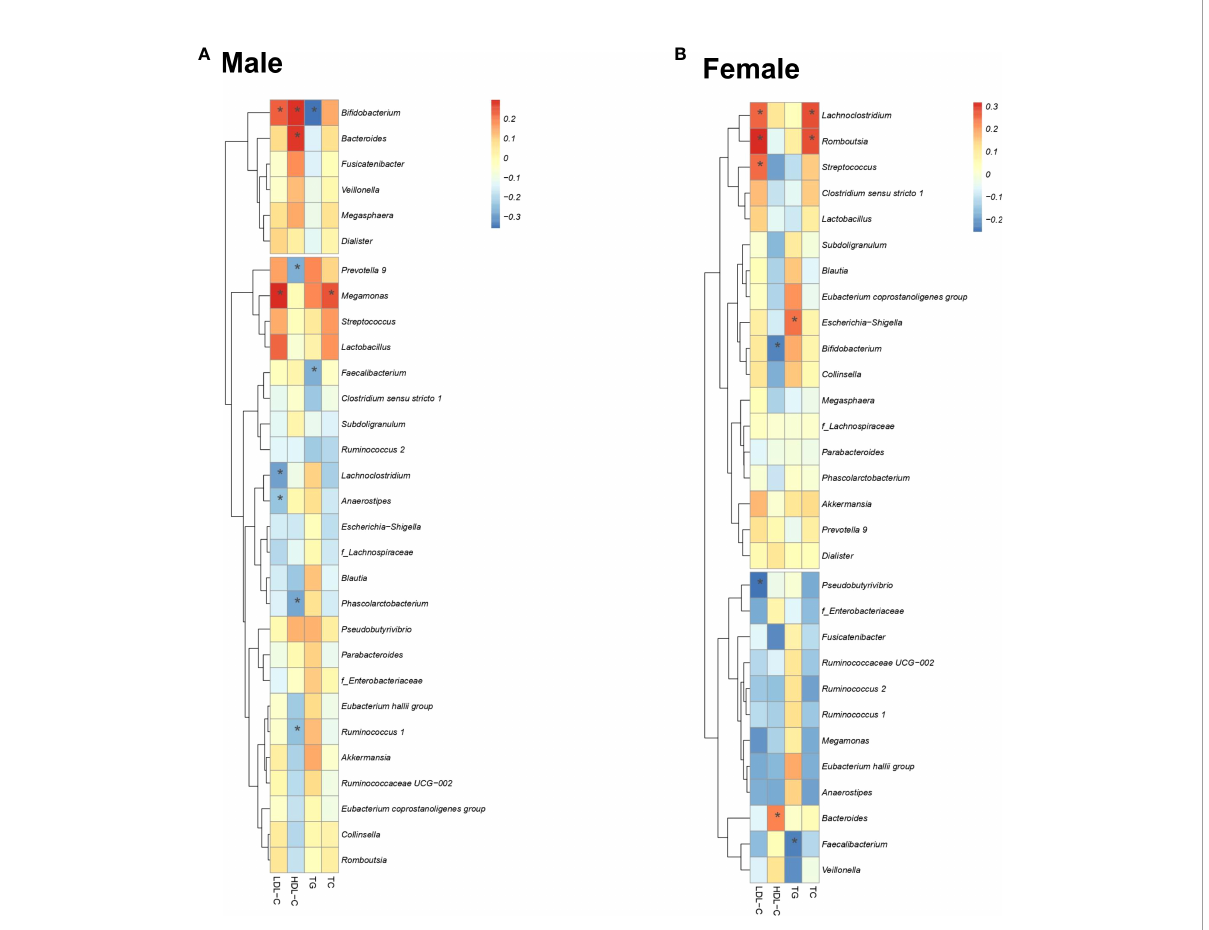
FIGURE 4 Correlation of four lipid pro fi les with important bacteria. Correlation between the lipid pro fi les and the presence ratio of three important bacteria. Spearman ’ s correlation coef fi cient determines the color intensity of the heat map. Red: positive correlation, blue: negative correlation. (*: P <